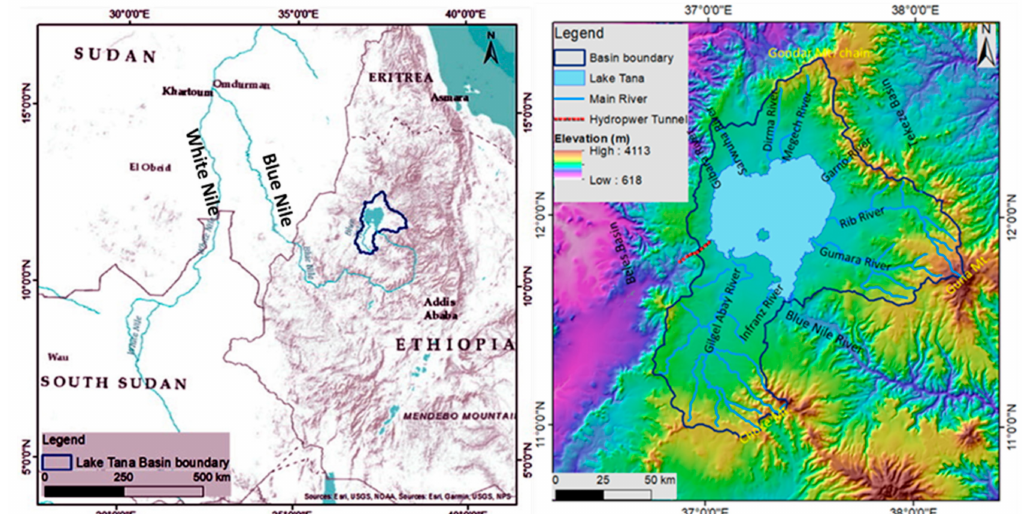
Figure 1. Location map of Lake Tana basin showing the topographical setup and main rivers. The Beles, the Blue Nile and the Tekeze basins are the major adjacent basins for Lake Tana Basin. The lake has two outlets: natural to the Blue Nile and through a tunnel to the Beles basins.